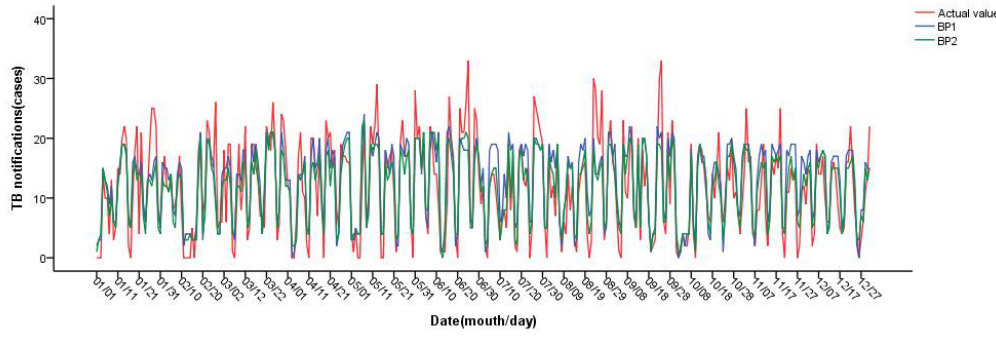
Figure 8. Prediction results of BP neural network.